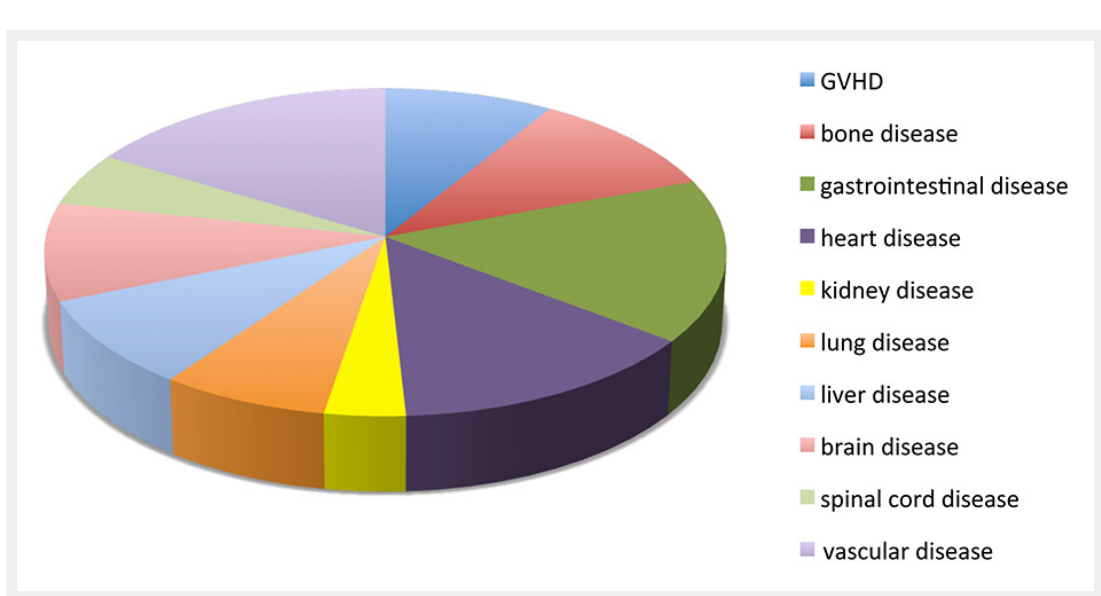
Summary of the main categories of disease present in the clinical trials that are completed, active or waiting for activation (registered as of July 15th, 2015 at http://clinicaltrial.gov). GVHD = graft versus host